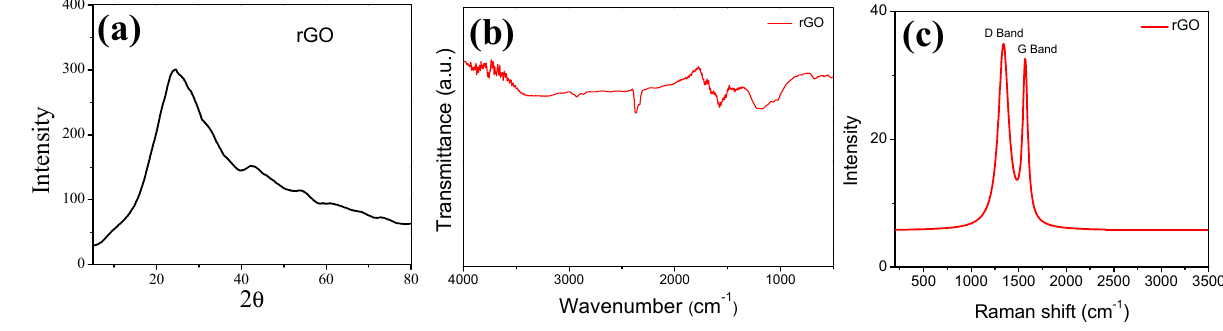
Figure 5. ( a ) rGO XRD pattern, ( b ) rGO FT-IR spectrum and ( c ) Raman spectrum of rGO .